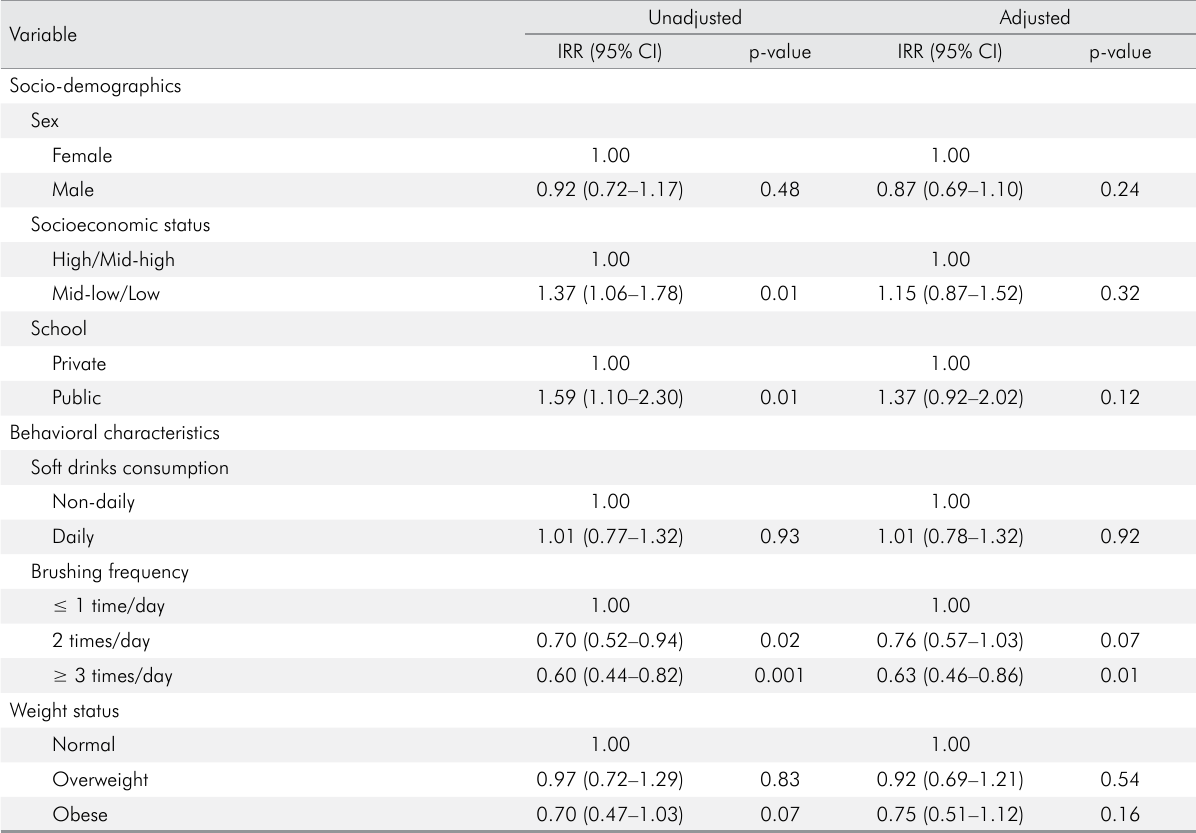
Table 3. Association between predictor variables and Δ DMFS (unadjusted and adjusted Negative binomial regression analysis, n =